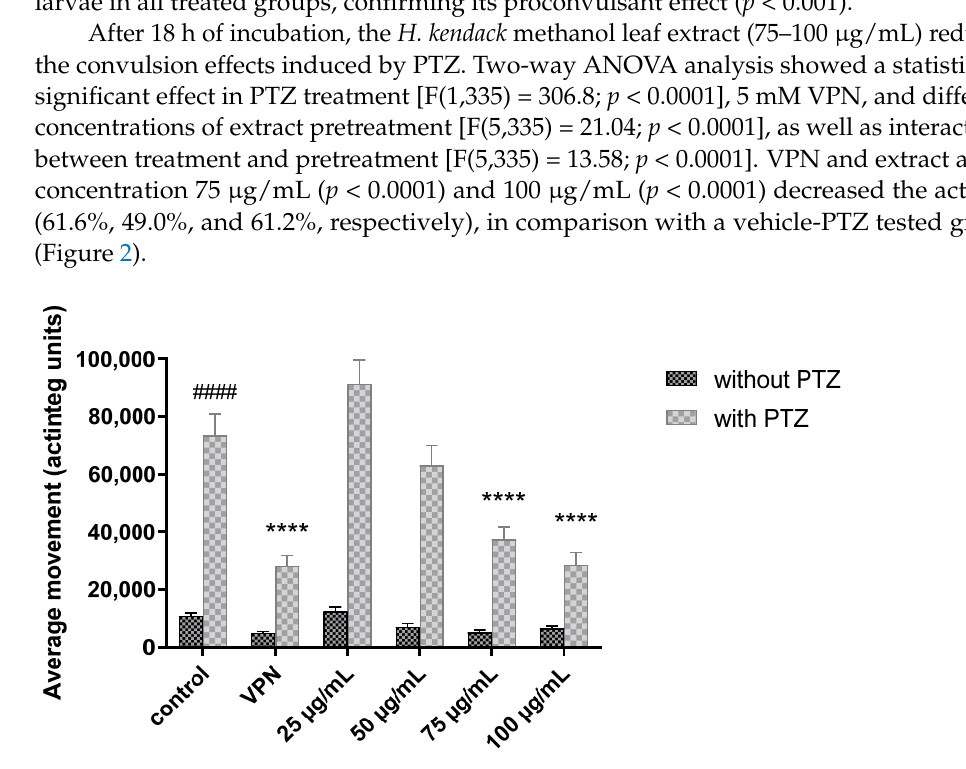
Figure 2. Anticonvulsant activity of Halfordia kendack methanol leaf extract and positive control (5 mM sodium valproate, VPN) after 18 h incubation prior to 20 mM pentylenetetrazole (PTZ) treatment (n = 30). Data represent means ± SEM; #### p < 0.0001 vs. vehicle-PTZ control group **** p < 0.0001 vs. PTZ-treated group (post-hoc Bonferroni test).